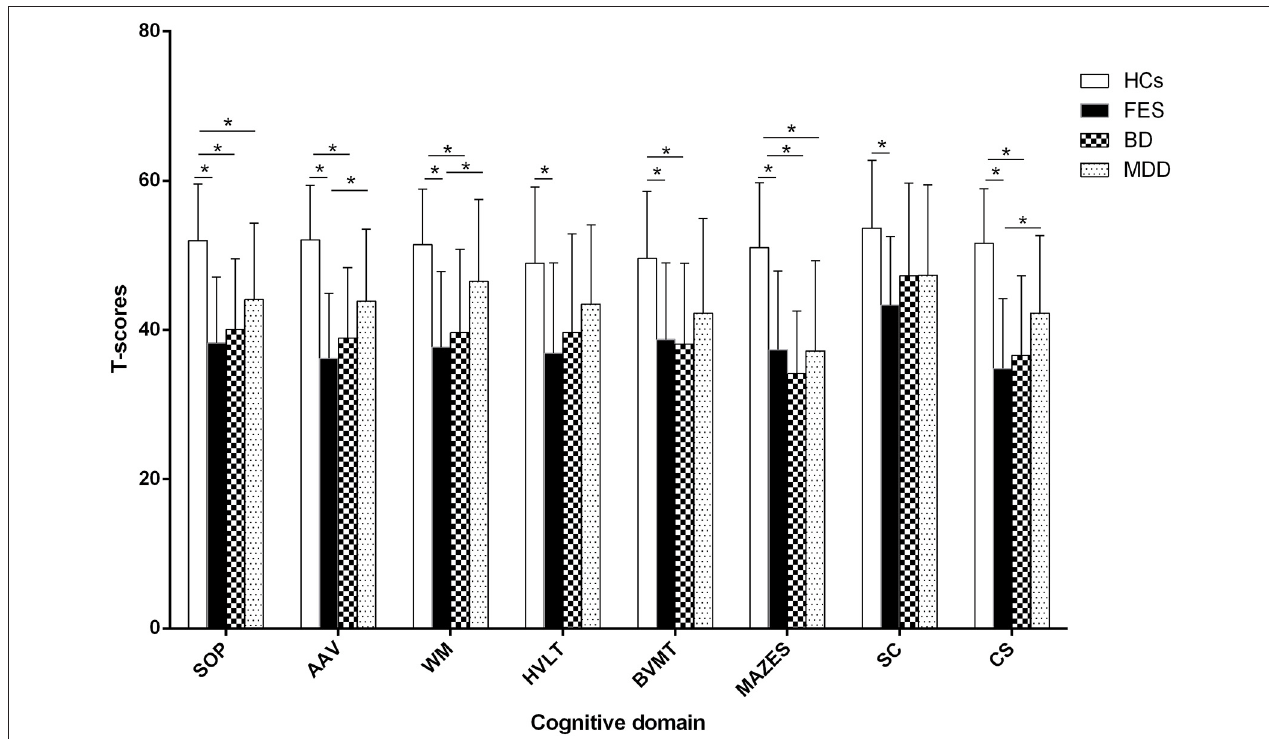
FIGURE 2 | Comparison of cognitive function among groups. * represents Bonfferoni corrected P < 0.05/7 = 0.007. SOP: speed of processing, AAV: attention and vigilance, WM: working memory, HVLT: Hopkins Verbal Learning Test, BVMT: Brief Visuospatial Memory TestM, SC: social cognition, CS: composite T-score, FES: first episode schizophrenia, BD: bipolar disorder, MDD: major depression disorder, HCs: healthy